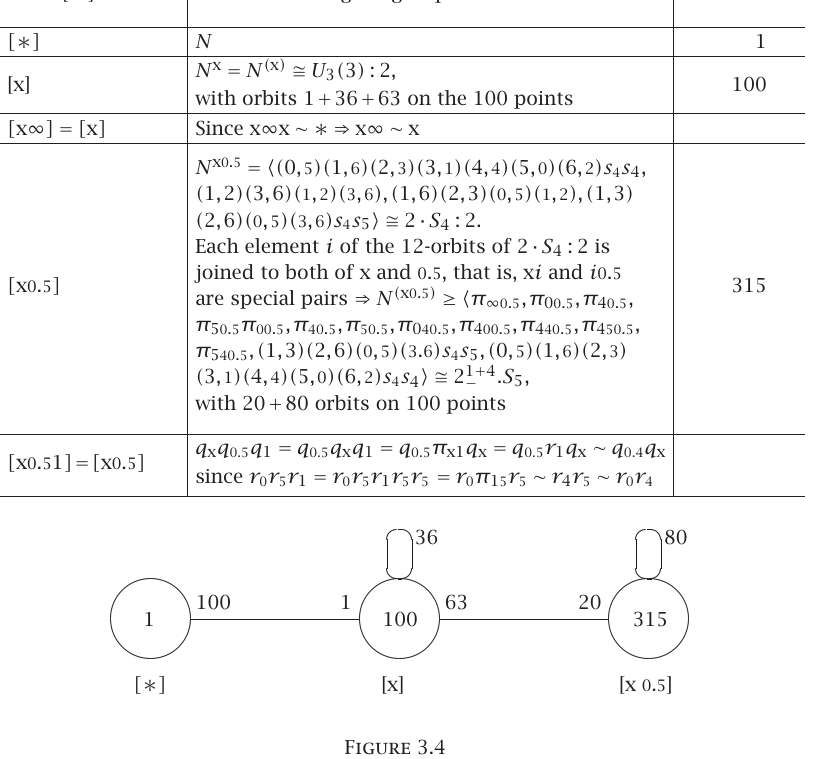
Table 3.3 . Double coset enumeration for G